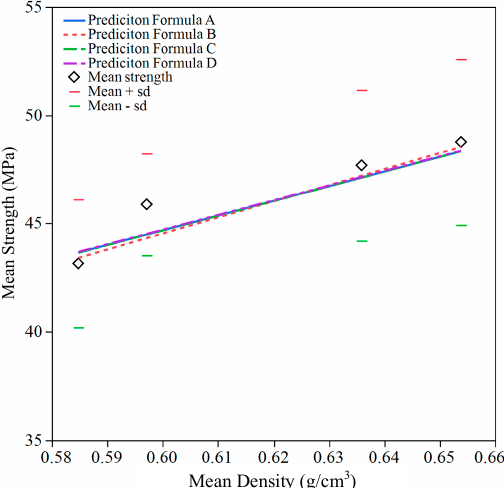
Figure 10. Average compressive strength of CLT, calculated using the prediction model.